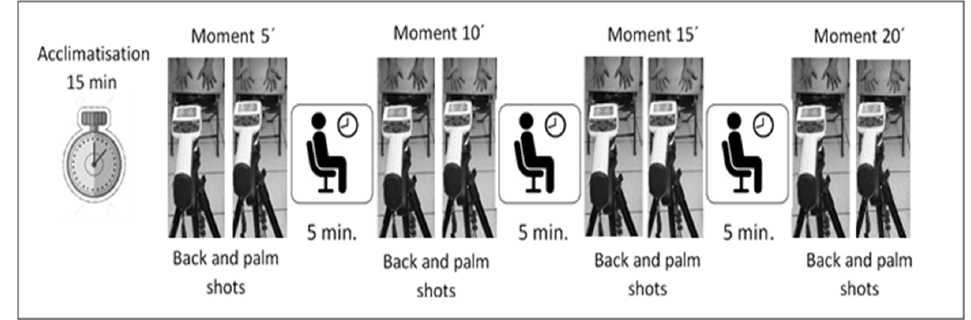
Figure 3. Experimental setup diagram.